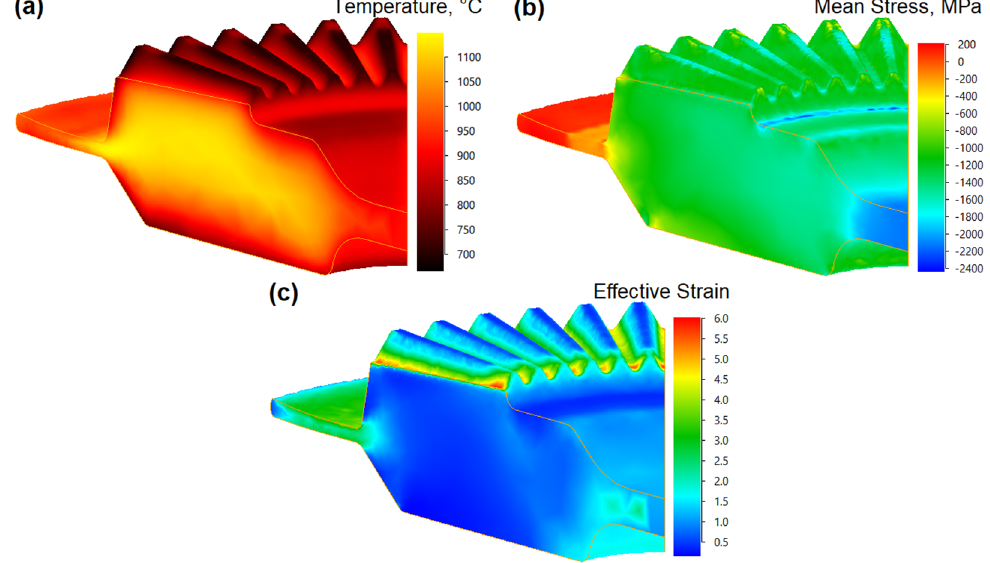
Figure 8. The results obtained for the temperature distribution: ( a ), mean stress ( b ), and effective strain ( c ) in the drop-forged Waspaloy gear wheel.